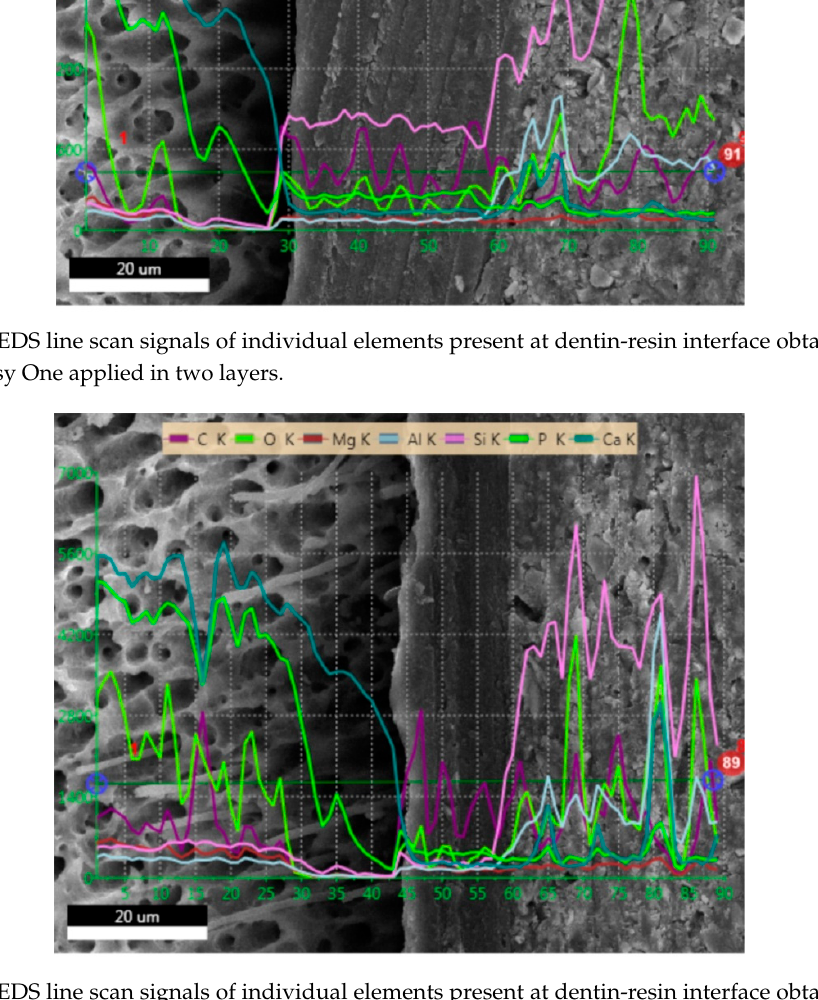
Figure 6. EDS line scan signals of individual elements present at dentin-resin interface obtained for Xeno V applied in two layers.